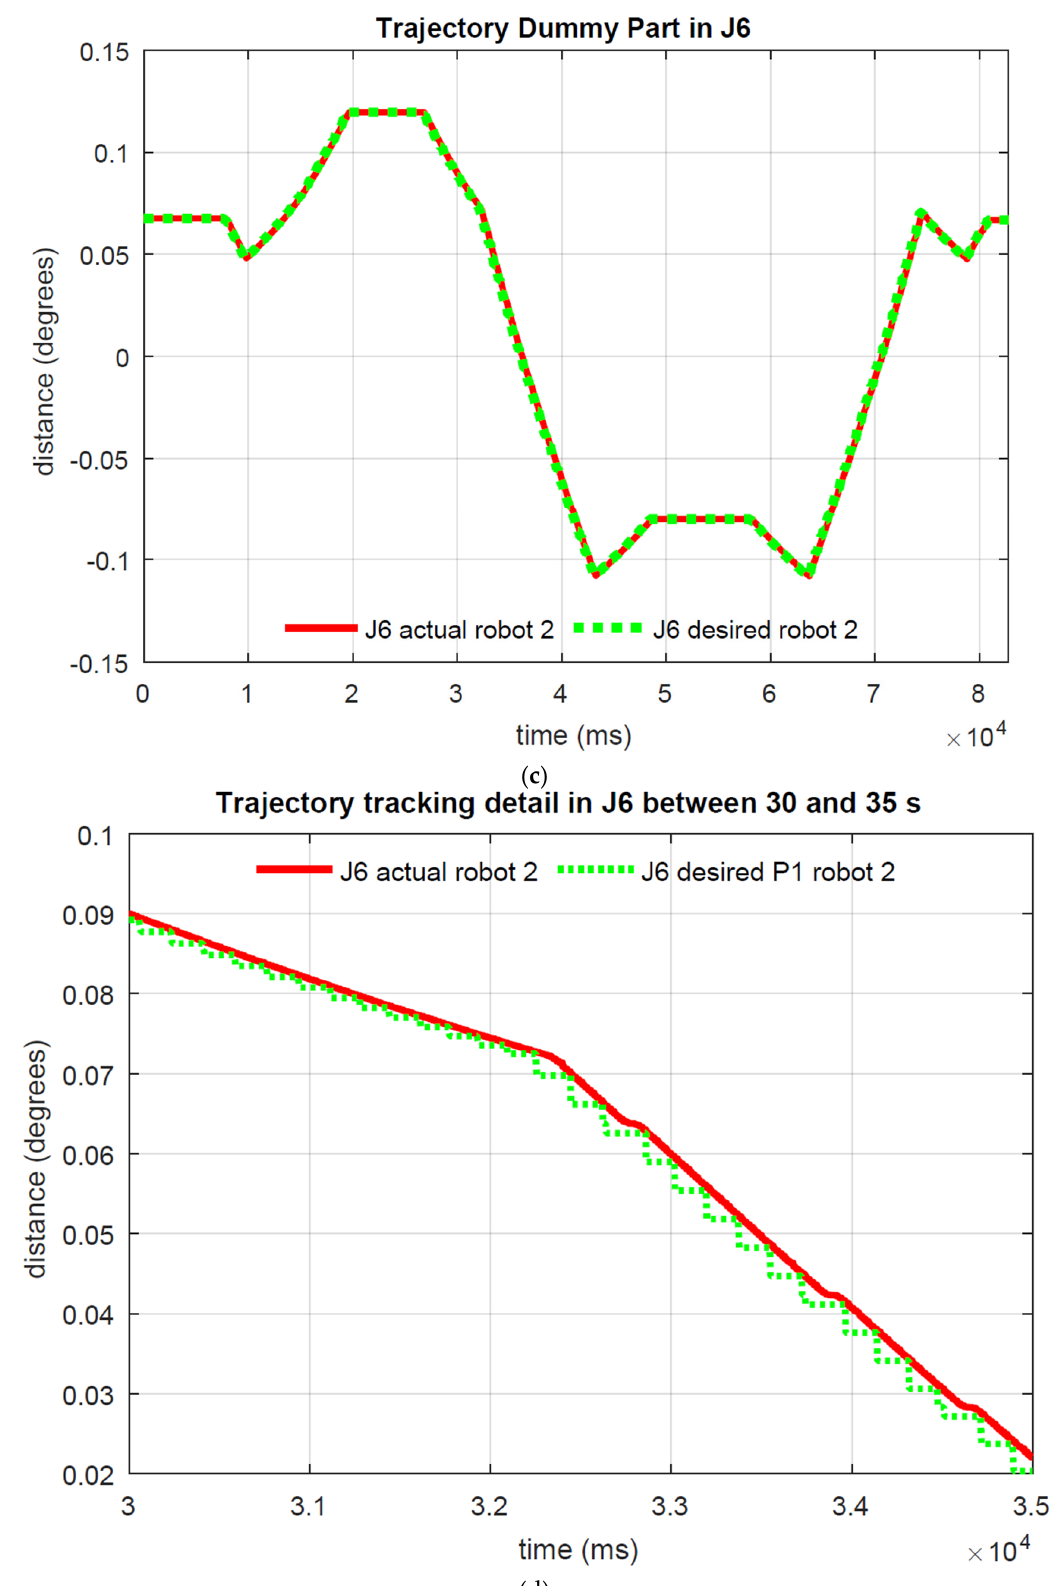
Figure 13. ( a ) Joint 6 trajectory (current and desired) for Robot 1. ( b ) zoom under 30 s and 35 s for Robot 1. ( c ) Joint 6 trajectory (current and desired) for Robot 2. ( d ) zoom under 30 s and 35 s for Robot 2.